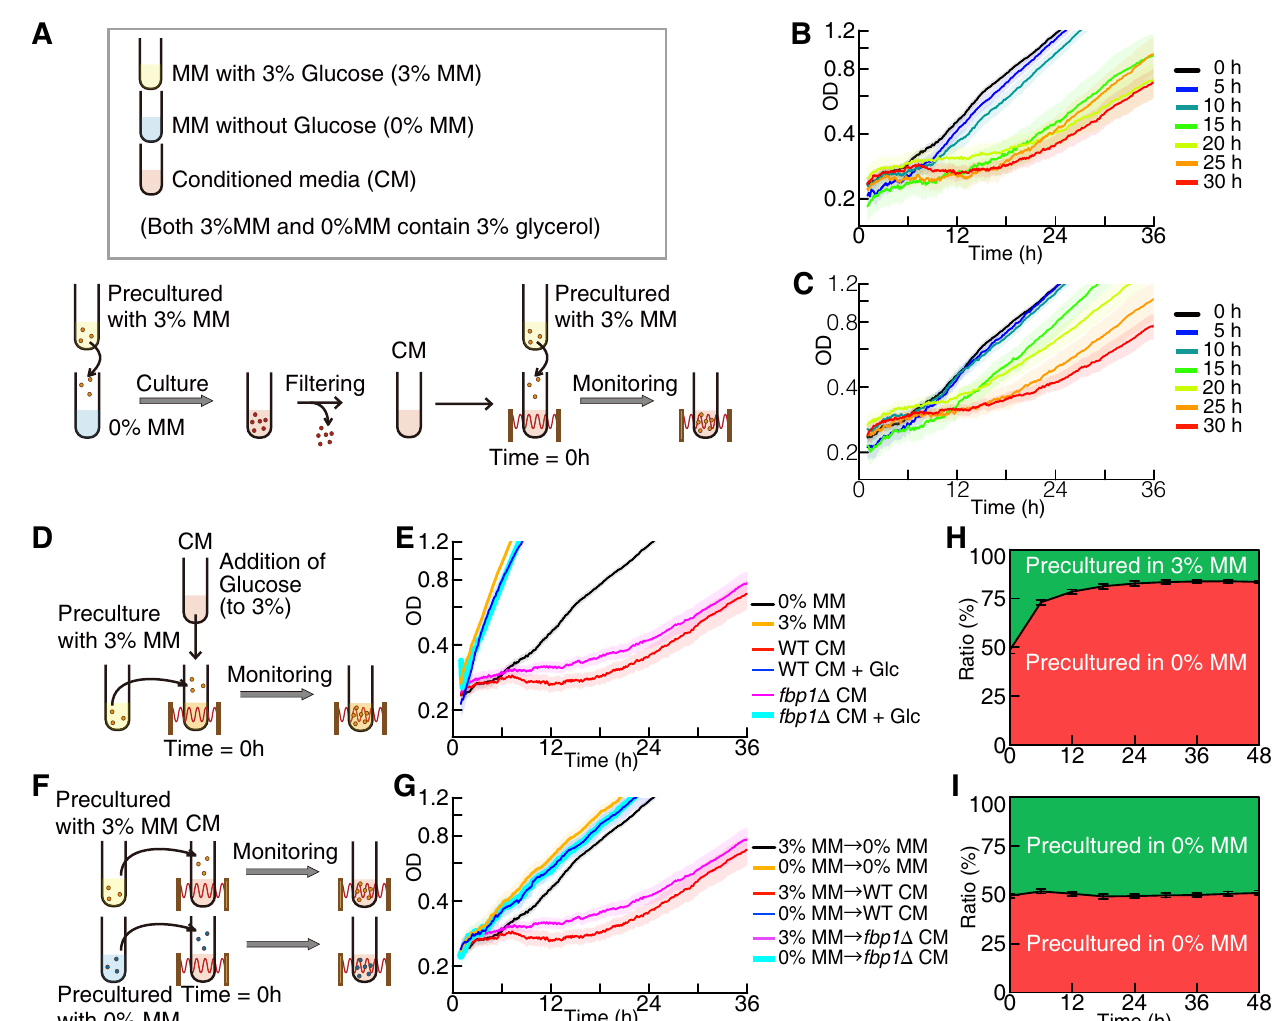
Fig 1. Conditioned media caused a delay phase of cell growth and latecomer killing during glucose depletion. ( A ) Schematic illustration of the experimental procedure for ( B ) and ( C ). ( B and C ) Growth curves of WT cells in ( B ) WT or ( C ) fbp1 Δ CM without glucose. Different colored lines indicate a moving average of OD measured every minute in CM with different incubation times. Each line is an average of n � 10 samples, and the pale-colored area indicates the SEM. ( D ) Schematic illustration of the experimental procedure for ( E ). ( E ) Growth curves of WT cells in CM with 3% glucose. Each line represents an average of n � 7 samples. ( F ) Schematic illustration of the experimental procedure for ( G ). ( G ) Growth curves of WT cells, precultured without glucose, in the CM. Each line represents an average of n � 7 samples. ( H and I ) Competition assay in WT CM ( H ) between the cells precultured in 3% and 0% MM and ( I ) between the cells precultured in 0% MM. Green and red areas indicate the fraction of mNeonGreen- and mCherry-labelled cells, respectively, and overwriting outline characters indicate preculture conditions. Black vertical bars between 2 areas indicate SEM (the number of each sample is 12). The data underlying this figure can be found in S1 Data. CM AU : AbbreviationlistshavebeencompiledforthoseusedinFigs 1 (cid:0) 4 : Pleaseverifythatallentriesarecorrect : , conditioned media; MM, minimal media; OD, optical density; SEM, standard error of the mean; WT, wild-